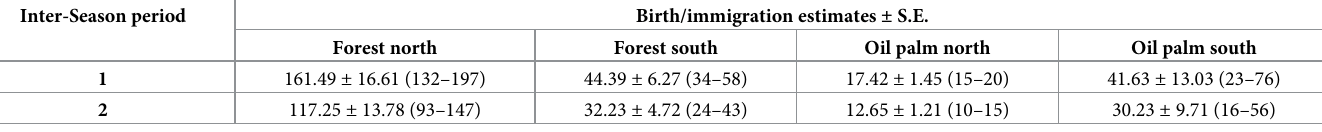
Values in parenthesis correspond to the range around the mean with a 95%